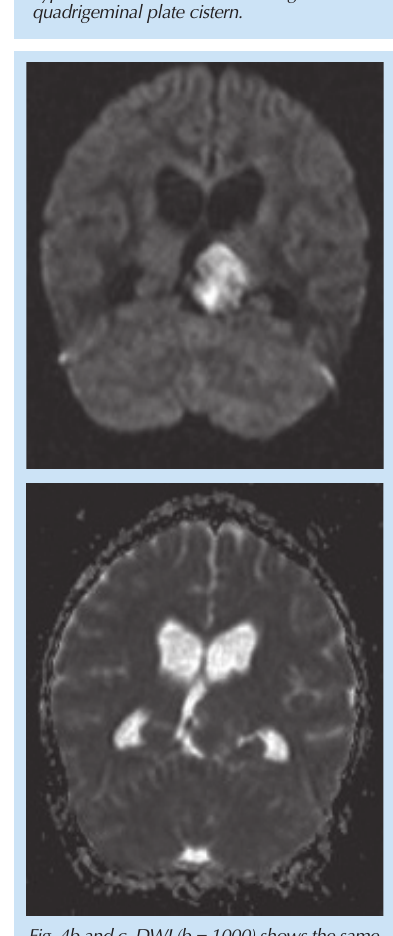
Fig. 3b and c. Corresponding DWI (b = 1000) the same lesion appears hyperintense (b), with restricted diffusion demonstrated on the ADC map (black)